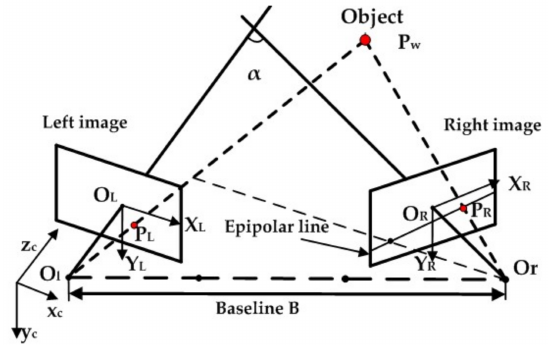
Figure 3. Principle of binocular stereo vision. O l − x c y left and right cameras, respectively. P w ( x point in the left camera coordinate, P L ( X of the projection points in the left and right image coordinates, respectively. B is the baseline of the stereo camera, α is the angle between two optic